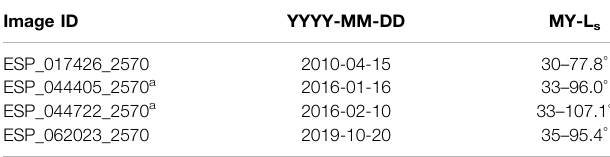
TABLE 1 | Orthorecti fi ed HiRISE images and their acquisition